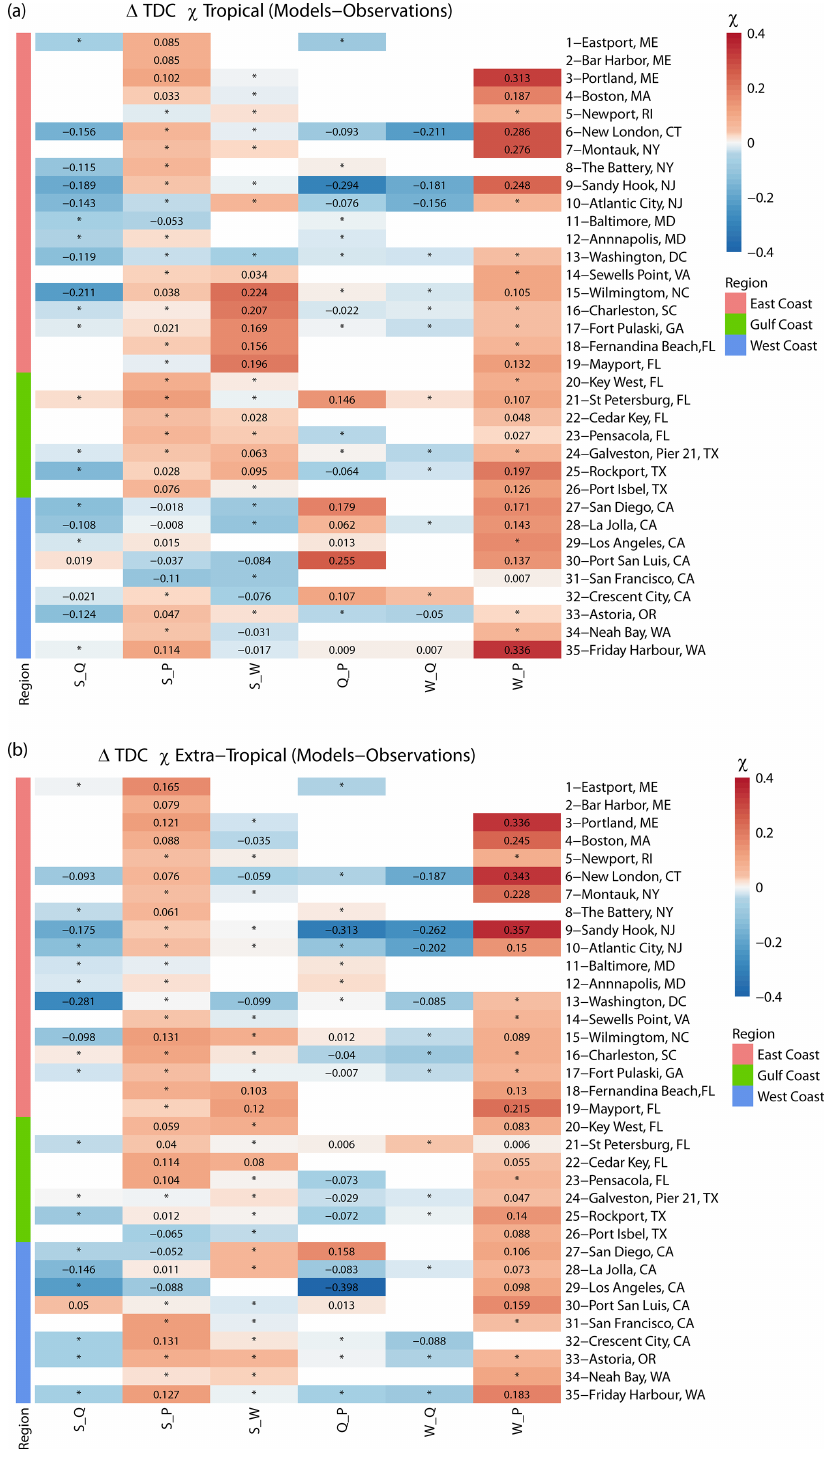
Figure 12. Heat map showing differences in extremal (tail) dependence (for q = 0 . 9) derived using observations and models, using a daily time series of both variables for tropical (a) and extra-tropical (b) season. Sites are grouped into locations on the East, Gulf, and West coasts (see colours on the left and in the legend). The colour bar denotes the difference between χ in the models versus observations, where the red colour denotes a higher dependence in the models, and the blue colour denotes higher dependence in the observations. Squares with an asterisk ( ∗ ) indicate that difference in dependence between models and observations is not significant. Blank squares indicate that data for the particular pair did not exist or that the number of overlapping years was less than